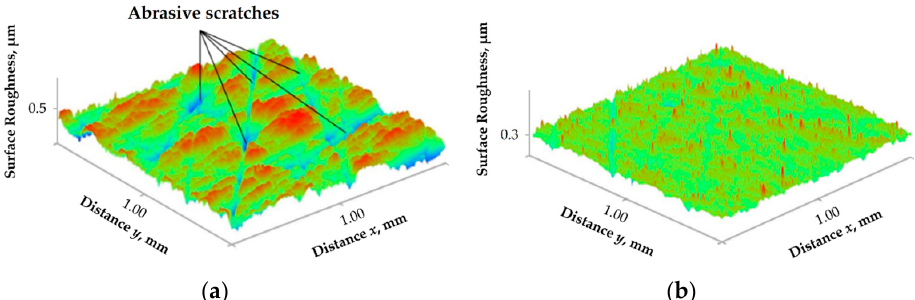
Figure 13. Topography of 80% (90 α 10 β ) + 20% TiN ceramic specimens surface areas: ( a ) before DLC coating deposition and ( b ) after DLC coating deposition.